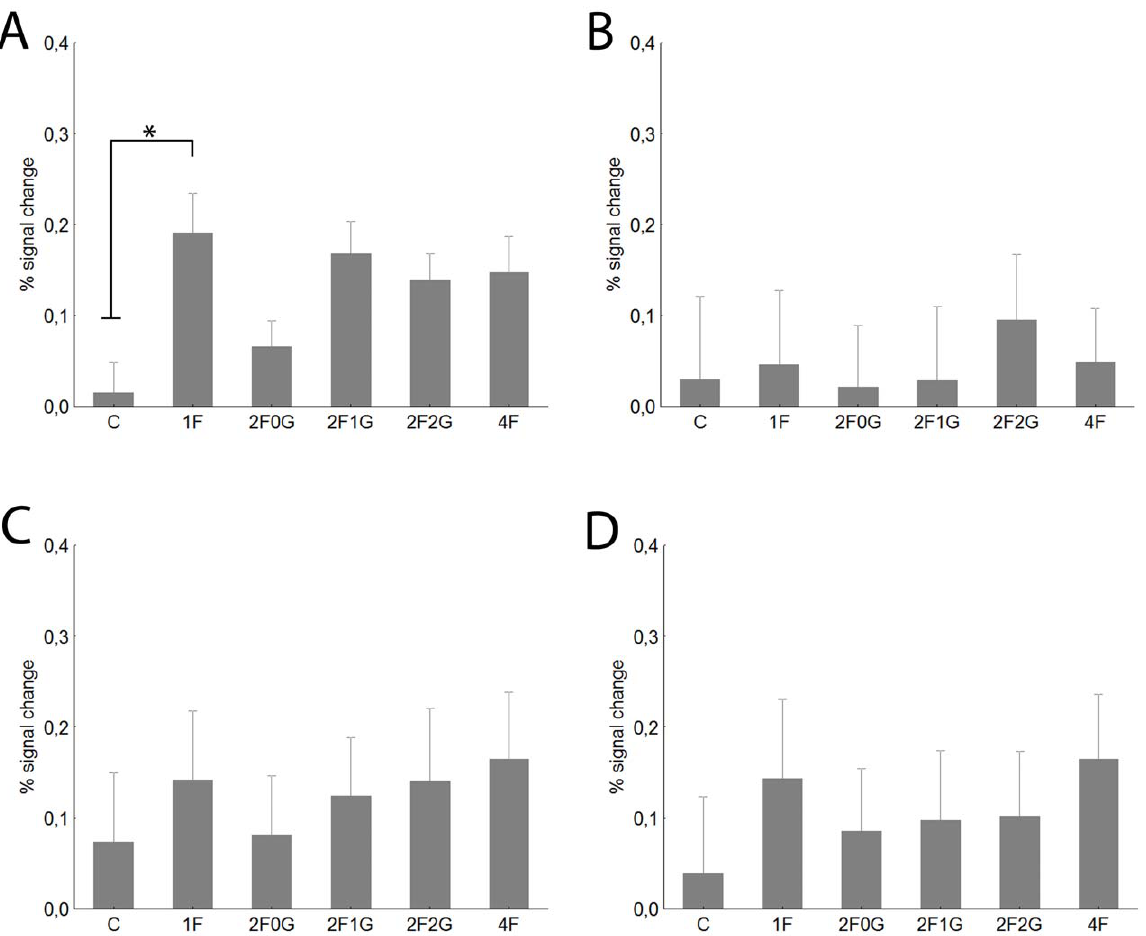
Figure 5. Average peak activation profiles ( ± standard error) of the OFA. Contralateral (rOFA: A, lOFA: C) and ipsilateral (rOFA: B, lOFA: D) stimulation. For conventions see Fig. 2